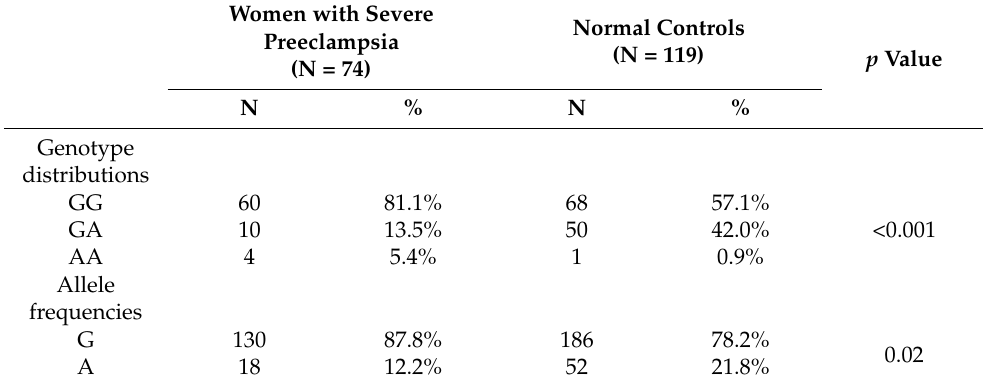
Table 3. Genotype distributions and allele frequencies of the NcoI polymorphism at the position -308 in the promoter region of the TNF- α gene among women with severe preeclampsia and normal